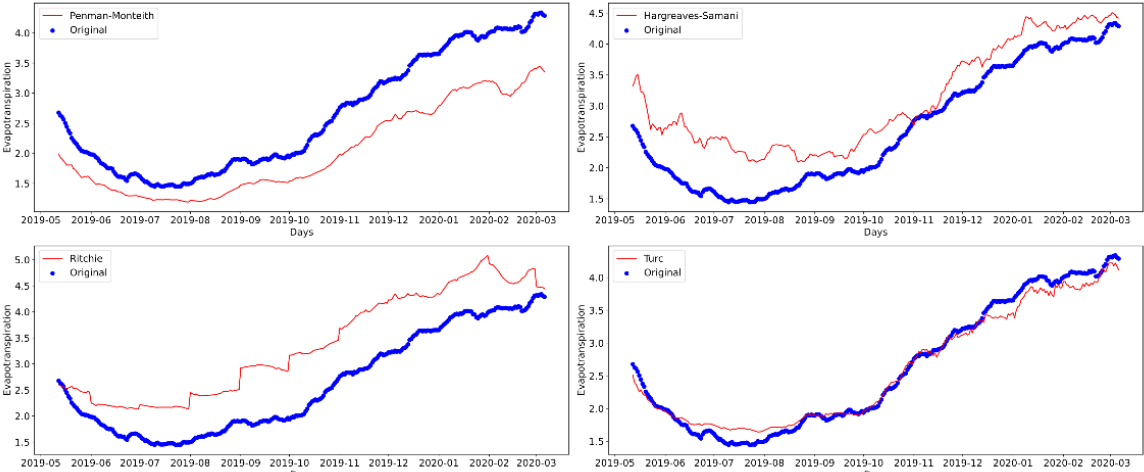
Figure 8. ETo calculated using the Penman-Monteith, Hargreaves-Samani, Ritchie, and Turc equations for 300 days, using climate variables predicted with neural networks compared with the actual data.